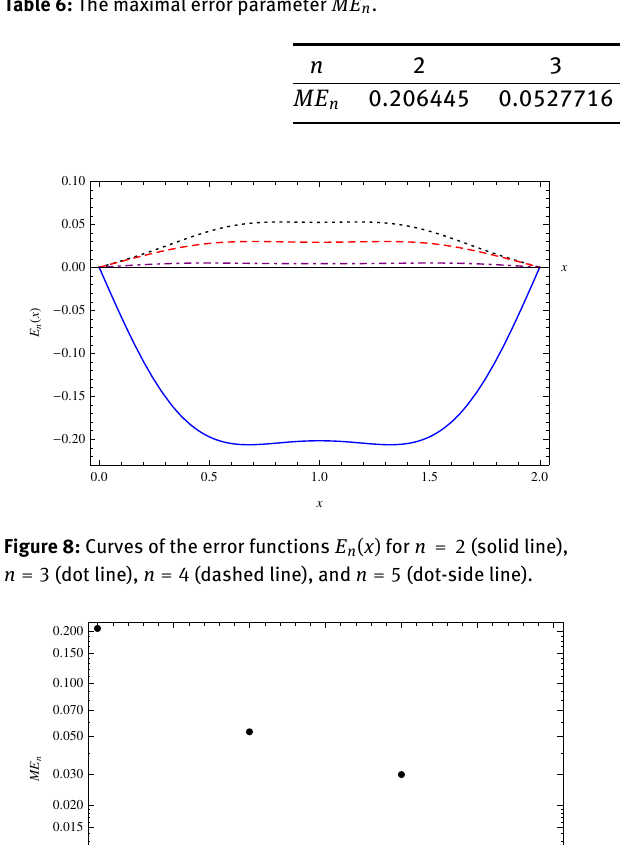
Table 6: The maximal error parameter ME n .